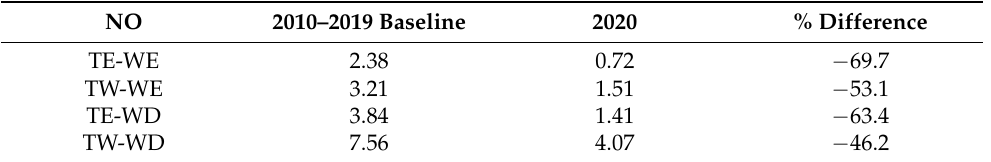
Table 1. The 3-month (April to June) aggregate results for NO for the baseline period (2010–2019) and 2020 and the percentage reduction for 2020 from the baseline period, analyzed for Toronto East (TE) and Toronto West (TW) for both weekends (WE) and weekdays (WD). NO